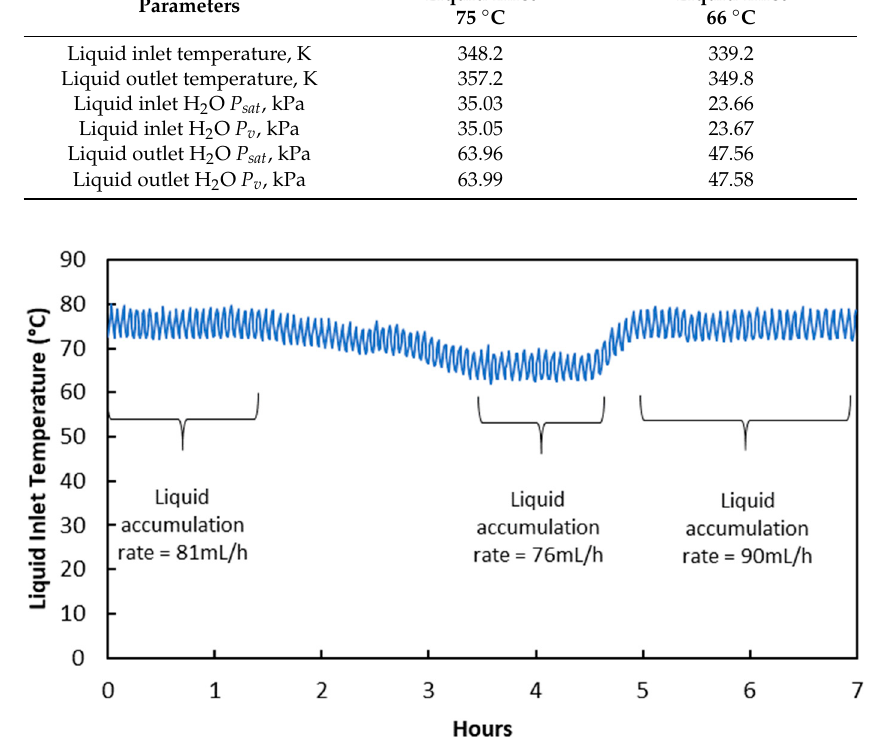
Figure 6. Changes in liquid temperature and its impact on liquid accumulation rate in treated gas knock-out drum.